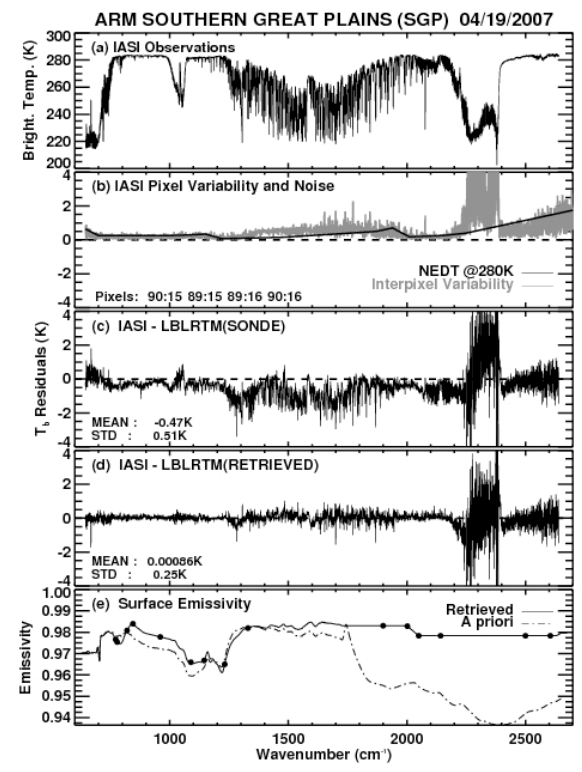
Fig. 5. (a) IASI measured spectrum in brightness temperature for the land case. (b) Spectra showing the variation within the four pix- els averaged to obtain the measurement vector. (c) IASI/LBLRTM comparison for full IASI wavenumber range with initial guess in- put. (d) Comparison after retrievals of surface temperature, surface emissivity, atmospheric temperature, H 2 O, O 3 , CH 4 , CO, OCS and HNO 3 . (e) Surface emissivity.